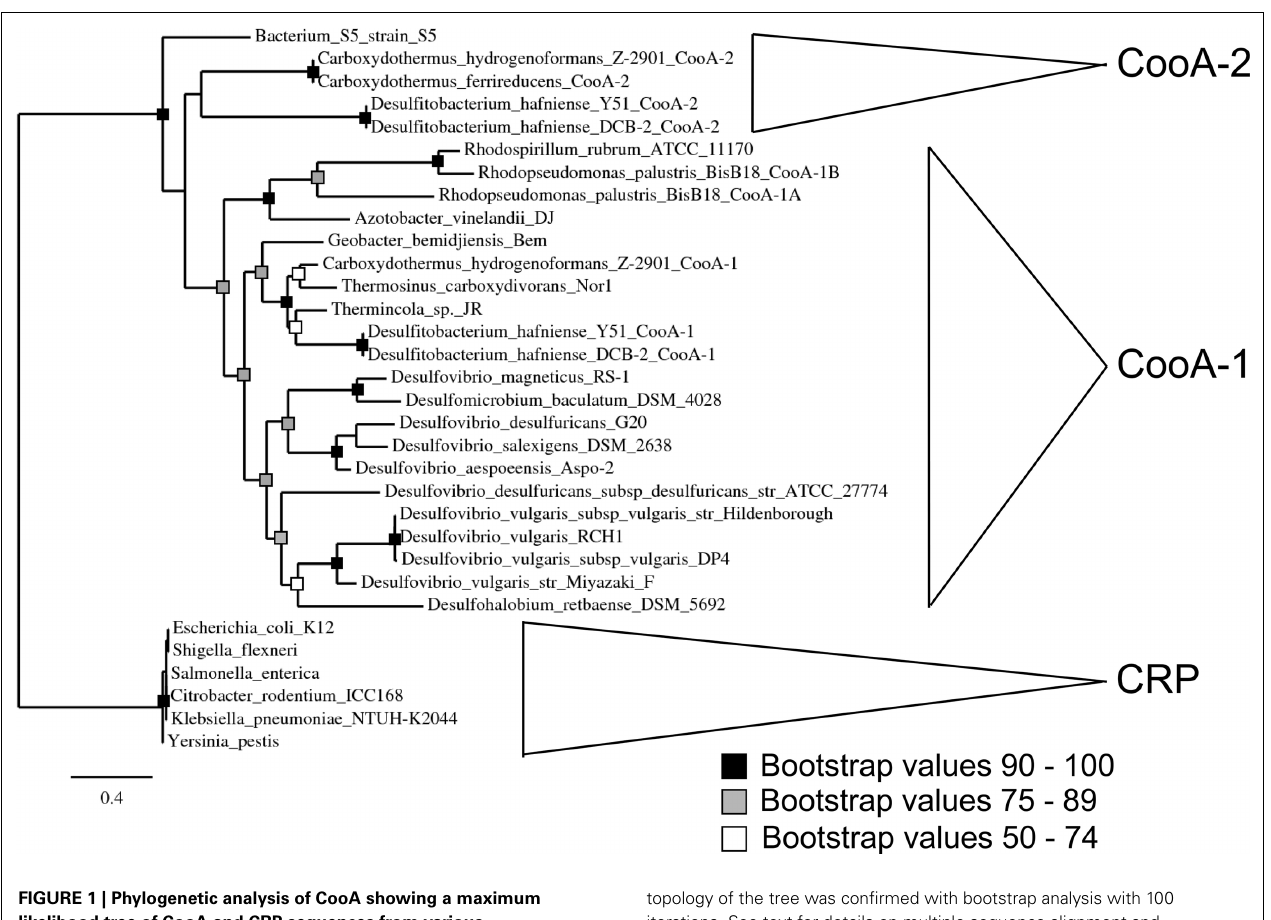
FIGURE 1 | Phylogenetic analysis of CooA showing a maximum likelihood tree of CooA and CRP sequences from various organisms. Major phylogenetic divisions are indicated on the tree.The